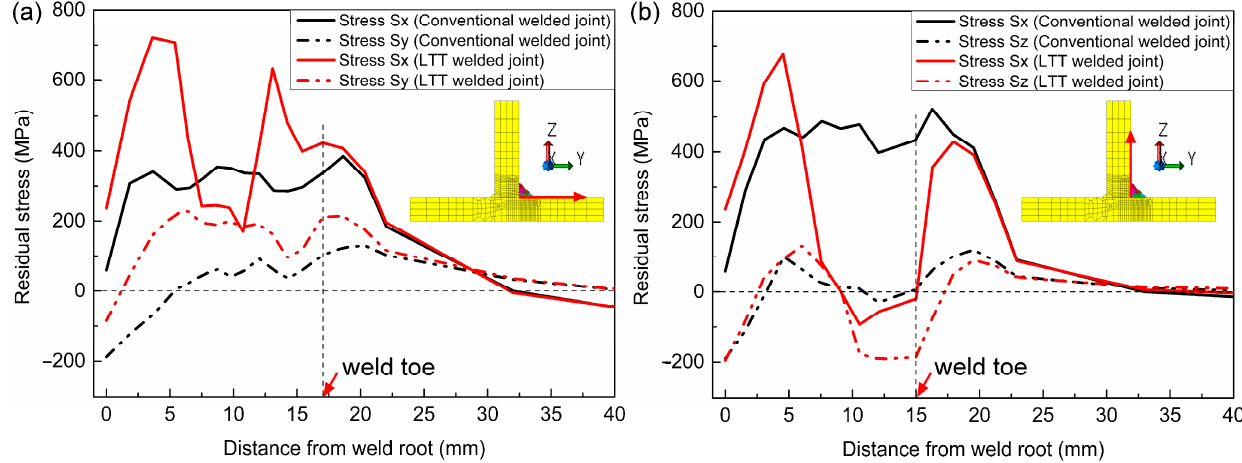
Figure 12. Comparison of the simulated residual stresses along the red line: ( a ) on the flange plate; ( b ) on the web plate.